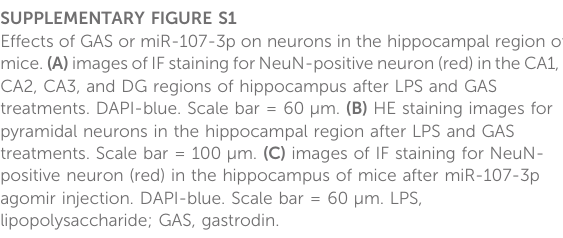
SUPPLEMENTARY FIGURE S1 Effects of GAS or miR-107-3p on neurons in the hippocampal region of mice. (A) imagesofIFstainingforNeuN-positiveneuron(red)intheCA1, CA2, CA3, and DG regions of hippocampus after LPS and GAS treatments. DAPI-blue. Scale bar = 60 μ m. (B) HE staining images for pyramidal neurons in the hippocampal region after LPS and GAS treatments. Scale bar = 100 μ m. (C) images of IF staining for NeuN- positive neuron (red) in the hippocampus of mice after miR-107-3p agomir injection. DAPI-blue. Scale bar = 60 μ m. LPS, lipopolysaccharide; GAS, gastrodin. SUPPLEMENTARY FIGURE S2 Diffusion conditions of miR-107-3p in the lateral ventricle and hippocampus of mice. (A) bromophenol bluestereotaxicinjection in the lateral ventricle and hippocampus of mice. (B) Sequence diagram of agomir miR-107-3p and NC. (C) Schematic diagram tereotaxic injection and fl uorescence expression map of miR-107-3p in the hippocampus and lateral ventricle of mice after 6, 12, and 24 h injection. scale bar = 120 μ m. LPS, lipopolysaccharide; GAS, gastrodin. SUPPLEMENTARY FIGURE S3 Expression maps of ABL2 and KPNA1 in tissues and organs. SUPPLEMENTARY FIGURE S4 The potential correlation analysis between KPNA1 and the in fl ammatory factor (TNF, IL-6, IL-1 β , IL-18 or MCP1) using GEPIA database. (A-E) The potential correlation analysis diagram between KPNA1 and TNF, IL-6, IL-1 β , IL-18 or MCP1, respectivly. Pearson correlation analysis of R and P -values were used. SUPPLEMENTARY TABLE S1 Primer sequences used in the quantitative RT-PCR